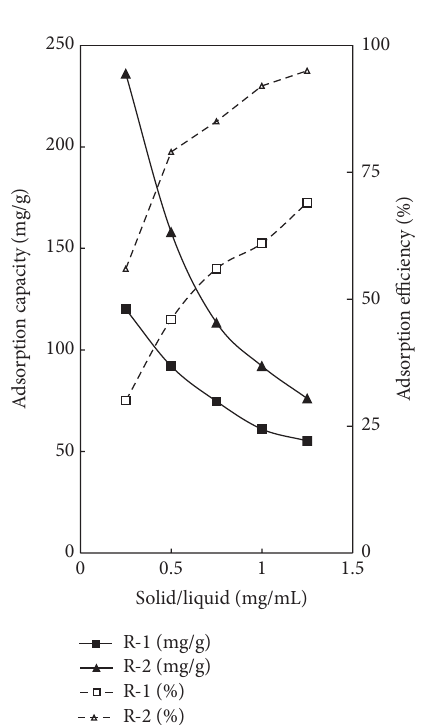
Figure 12: The effect of the solid/liquid ratio on the adsorption